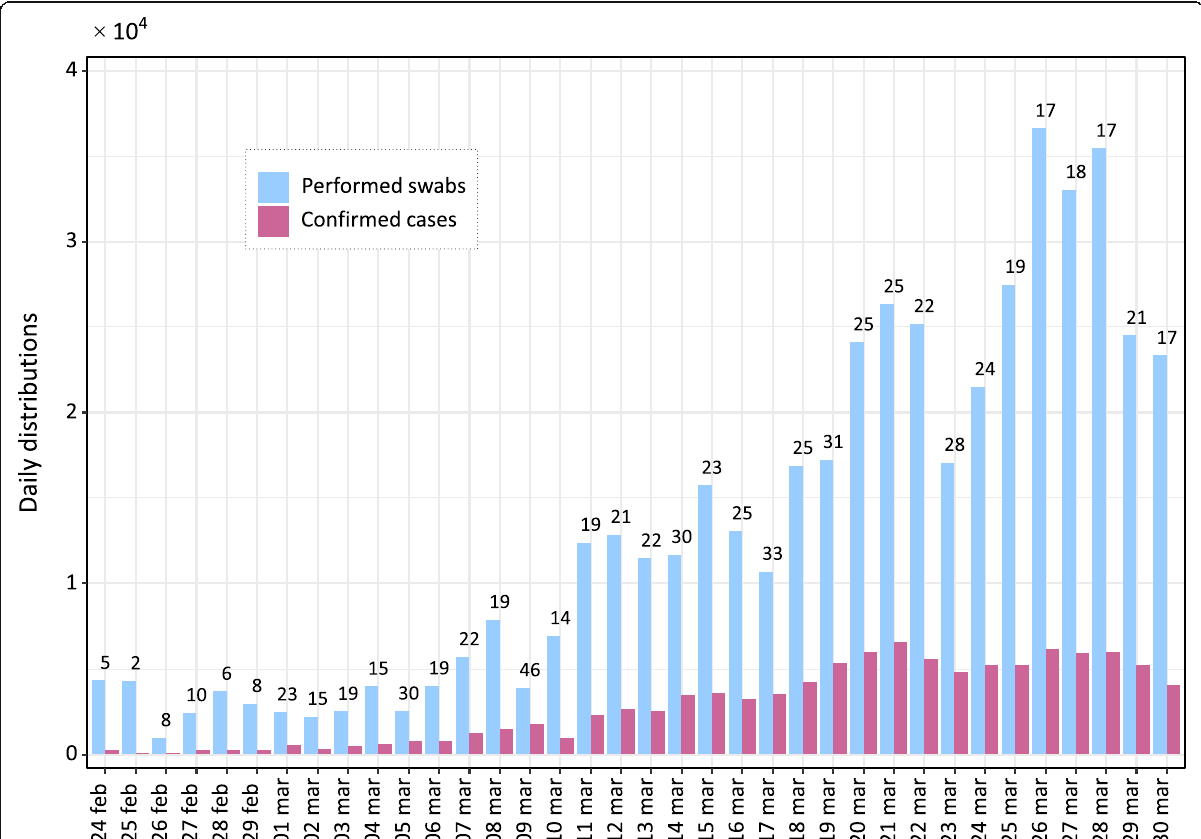
Fig. 1 Daily distribution of the performed swabs and confirmed cases. The numbers are related to the ratio, in percentage, between confirmed cases and performed